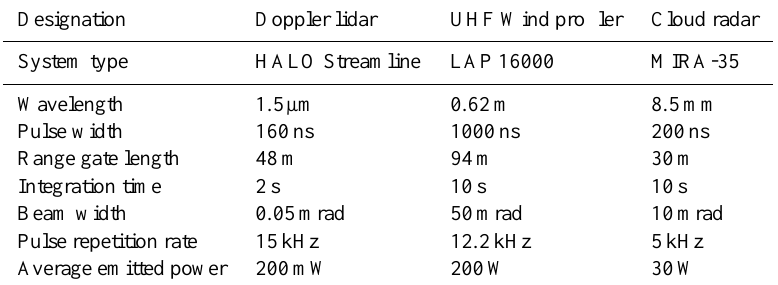
Table 1. Technical properties of the three main instruments involved in the combined measurements.